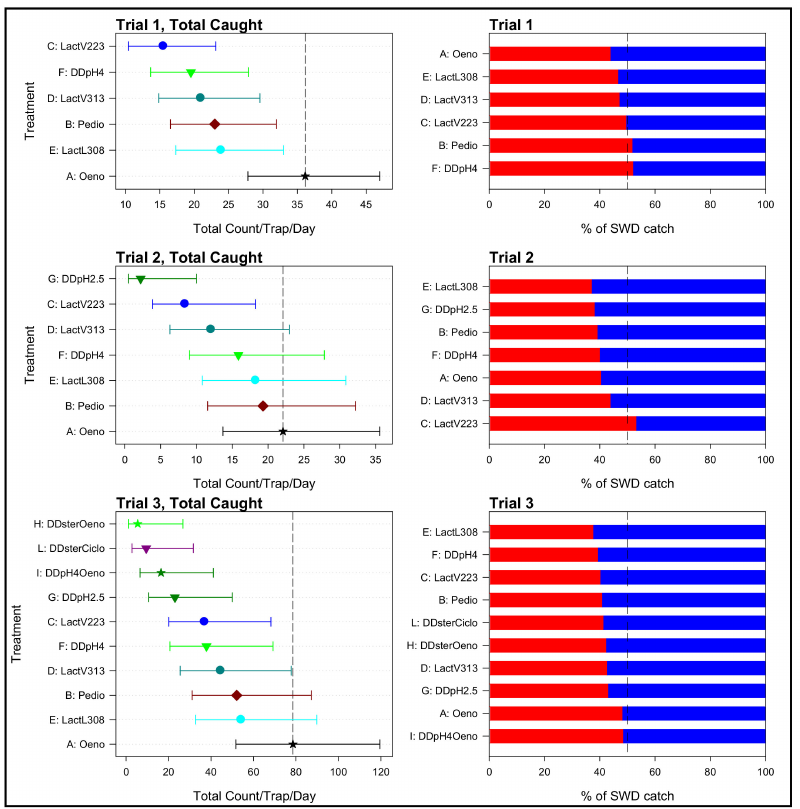
Figure 1. Left: Mean total SWD caught per trap per day for the three trials (including the final assessment, trial 3), with treatment in increasing order of the mean. Error bars are 95% confidence limits, and vertical dashed line is at the mean fortreatment A. Right: percentage of the total SWD that were female or male, for each of the three trials. Treatments are in increasing order of the % female. Dashed vertical line is at 50%. The red color indicates the percentage of caught females and the blue color indicates the percentage of caught